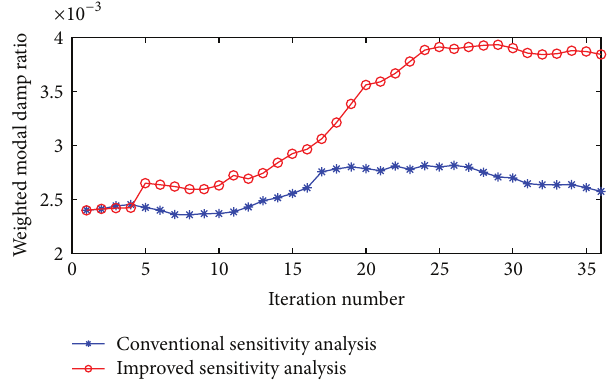
Figure 13: Iteration histories of the modal damp ratio.